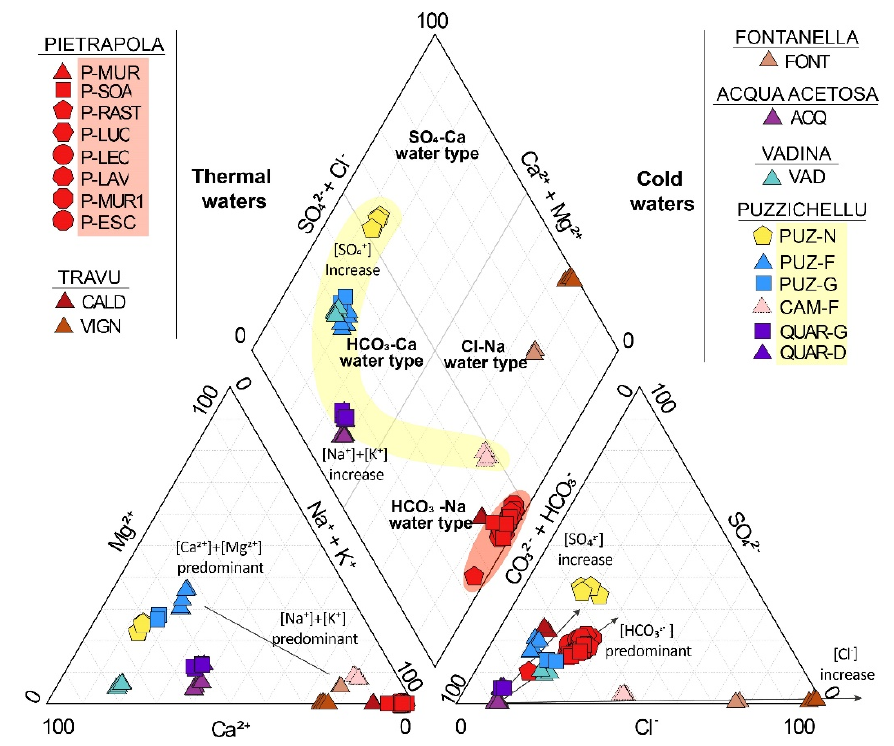
Figure 3. Piper diagram of Eastern Corsica thermo-mineral groundwater (N = 84). The spring group of Pietrapola is displayed in red background while Puzzichellu is displayed in yellow background.